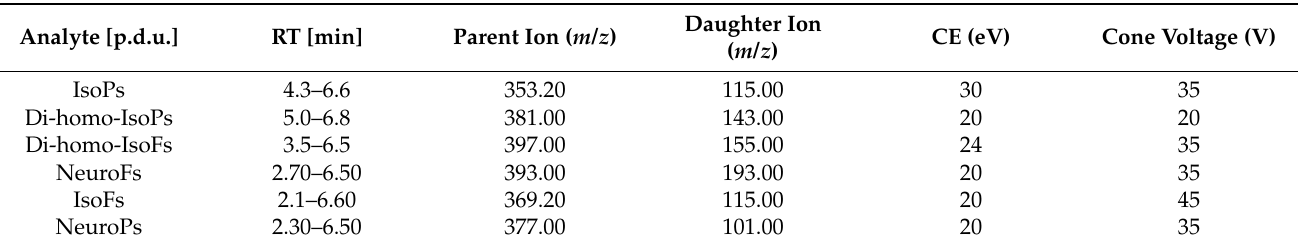
Table 1. Mass spectrometric parameters and chromatographic windows employed for the lipid peroxidation biomarkers. Analyte